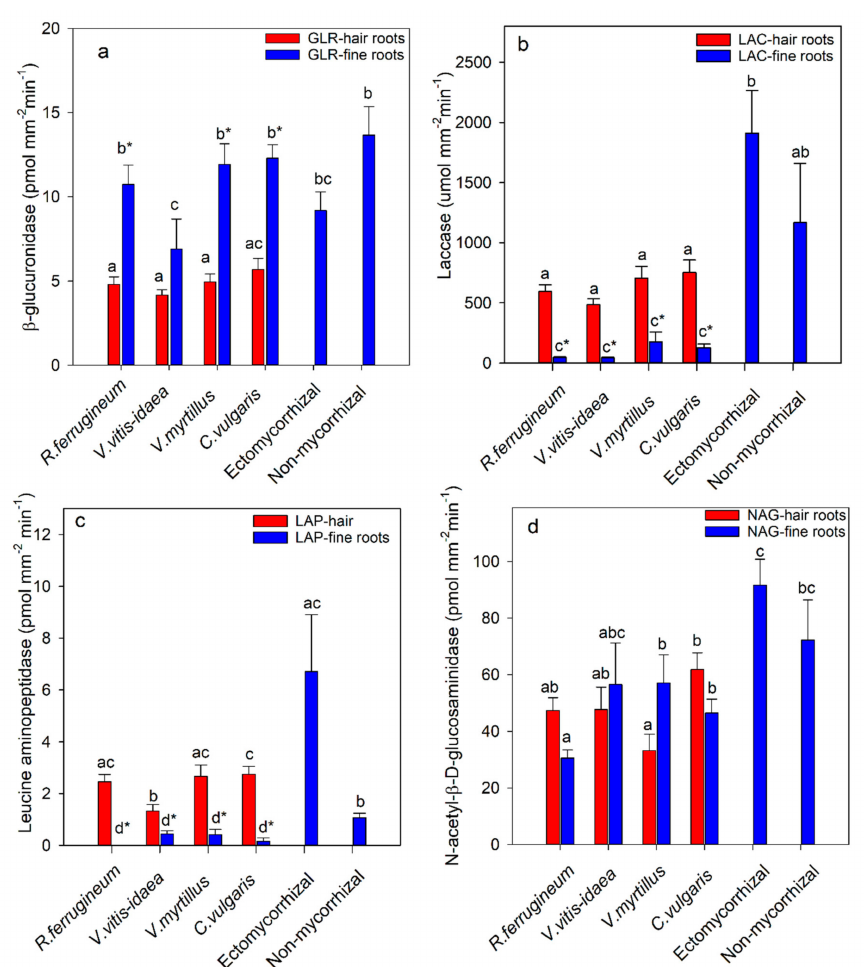
Figure 1. β -glucuronidase ( a ), laccase ( b ), leucine amino peptidase ( c ), and N -acetyl- β - D -glucosaminidase ( d ) activity of fine roots and hair roots of ericaceous species ( Rhododendron ferrugineum , Vaccinium vitis-idaea , Vaccinium myrtillus , or Calluna vulgaris ) and ectomycorrhizal and non-mycorrhizal root tips of Picea abies at tree line (1668 to 1791 m). The activity is calculated on the basis of projected surface area. The roots were collected at the Wasserberg, Gaal in the central Alps, Austria. Bars show means ± SE. Bars not followed by the same letters are significantly different ( p ≤ 0.05) among ericaceous species, ectomycorrhizal species, or non-mycorrhizal roots tips (ab). Asterisks indicate significant differences between hair roots and fine roots for the same ericaceous species ( p ≤